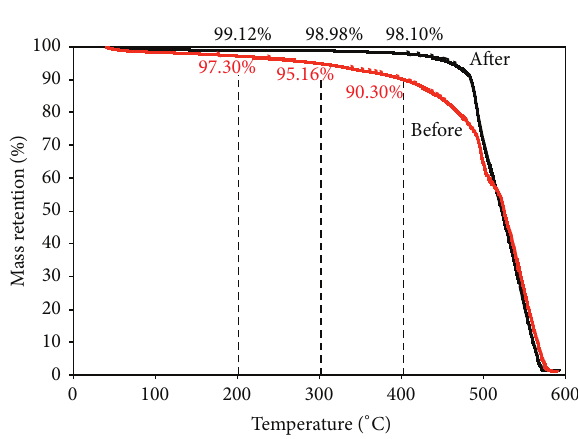
Figure 6: Thermogravimetric analysis of GNPs before and after annealing/hydrogenation.